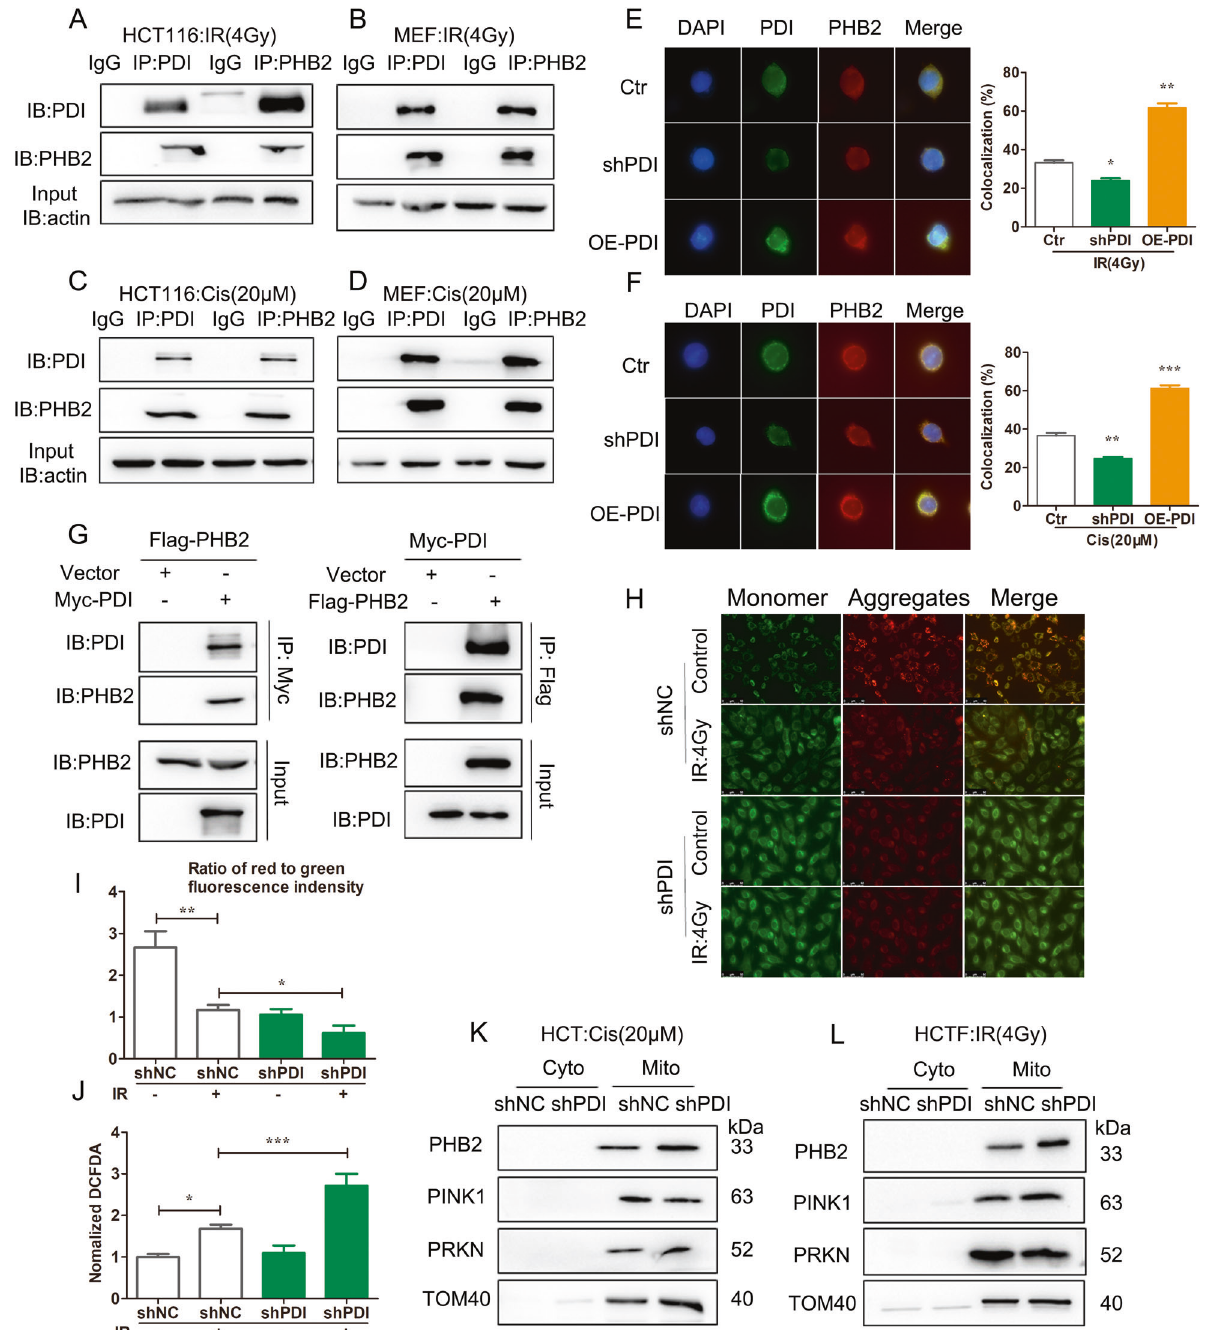
Fig. 6 PDI prevents autophagy by regulating mitophagy. A – D The interaction between PDI and PHB2 was detected by immunoprecipitation after the treatment with γ -ray (4 Gy) irradiation ( A , B ) or 20 μ M cisplatin ( C , D ) for 24 h in HCT116 and MEF cells. E , F Immuno fl uorescence microscope analysis of co-localization of PDI (red) and PHB2 (green) in PDI knockdown or PDI overexpression HCT116 cells after 24 h of treatment with IR (4 Gy) ( E ) or cisplatin (20 μ M) ( F ). Blue DAPI staining was used to stain the cell nucleus. Scale bar = 25 μ m. G The interaction between PDI and PHB2 was detected by Flag-pull down in vitro. Puri fi ed Flag-PHB2 or Myc-PDI immobilized on the beads was incubated with puri fi ed Myc-PDI or Flag-PHB2. Input and bead-bound proteins were analyzed by immunoblotting with anti-PDI or anti-PHB2 antibodies. H The changes in the MMP of HCT116 cells before and after γ -ray (4 Gy) irradiation for 24 h were detected by the JC-1 probe. I Statistical map of MMP. J The expression of ROS in HCT116 cells after γ -ray (4 Gy) irradiation for 24 h. K , L Expression of mitophagy- related proteins in mitochondria treated with γ -ray (4 Gy) irradiation ( K ) after 24 h in HCT116 cells or treated with cisplatin (20 μ M) after 24 h in MEF cells ( L ). Data were pooled from three independent experiments and the results are represented as mean ± SD; * P < 0.05, ** P < 0.01, *** P <